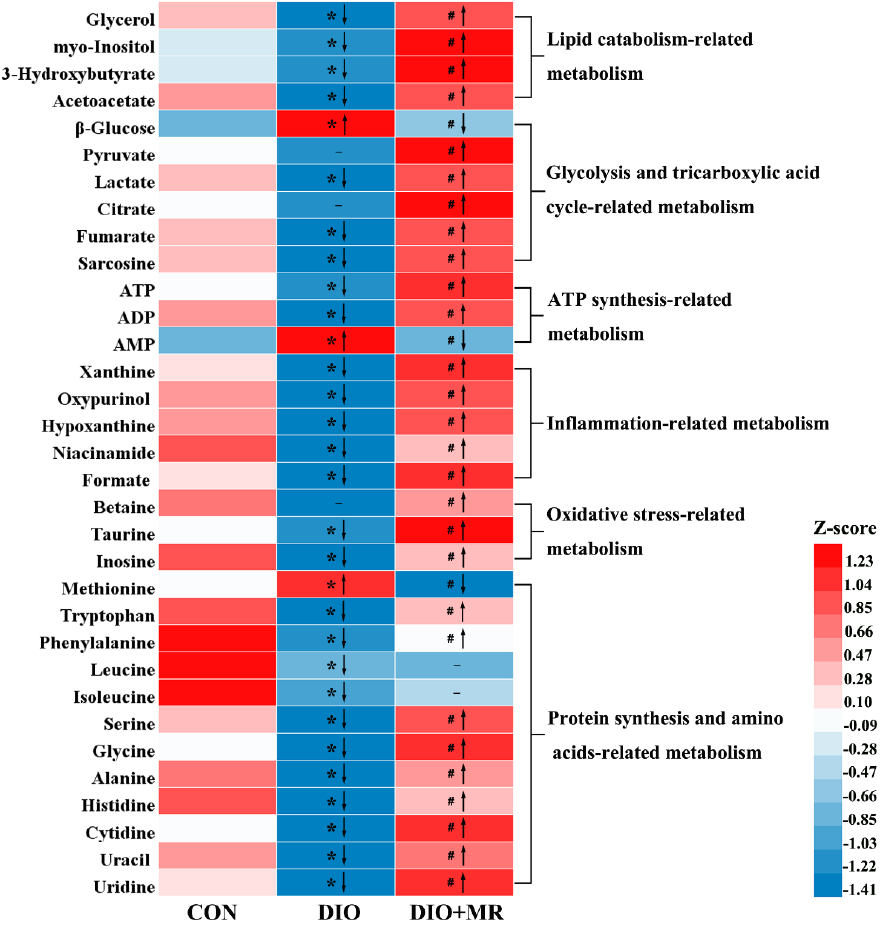
Figure 6. Potential metabolite markers in spleen tissues. The heat map shows normalized relative metabolite levels using the equation Z-score = (value in each sample—average value in all samples)/ (standard deviation of value in all samples). Only when simultaneously meeting VIP > 1.00 (variable importance in the projection values) and p < 0.05 (one-way ANOVA and Tukey’s test) were the variables ultimately confirmed as potential metabolic biomarkers. “ ↑ / ↓ ” indicate significantly increased/decreased; “-” means insignificant. All data are shown as mean ± SEM ( n = 10). * p < 0.05 versus CON; # p < 0.05 versus DIO.